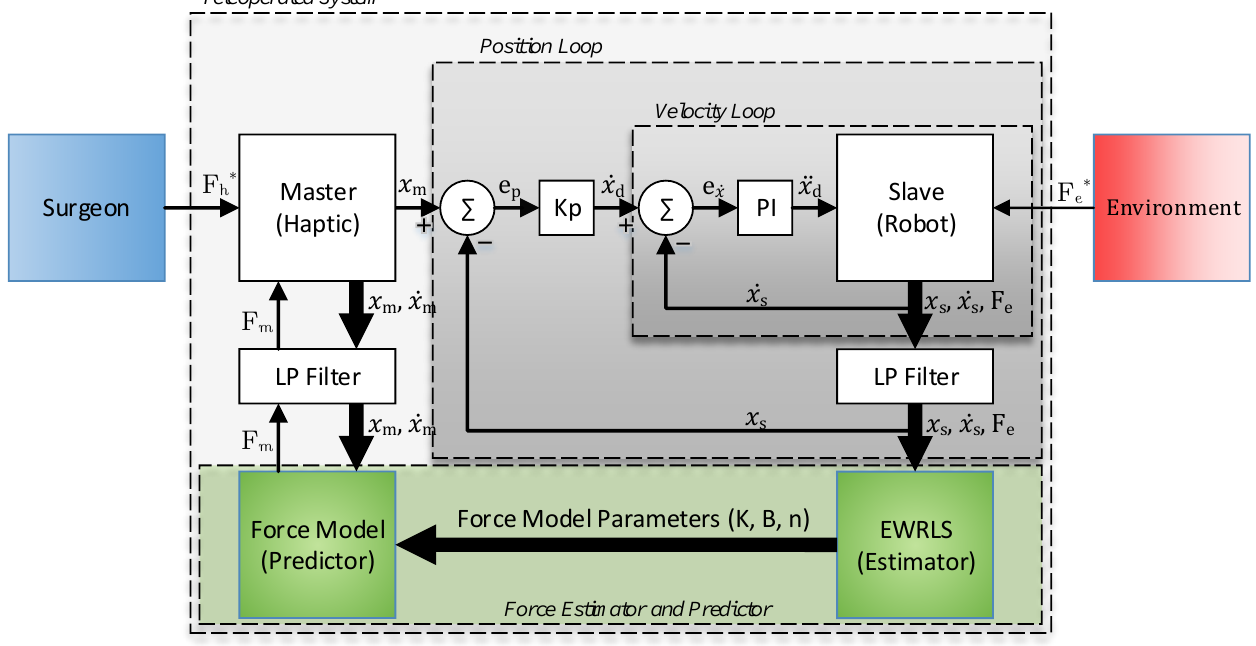
Figure 3. Proposed teleoperator